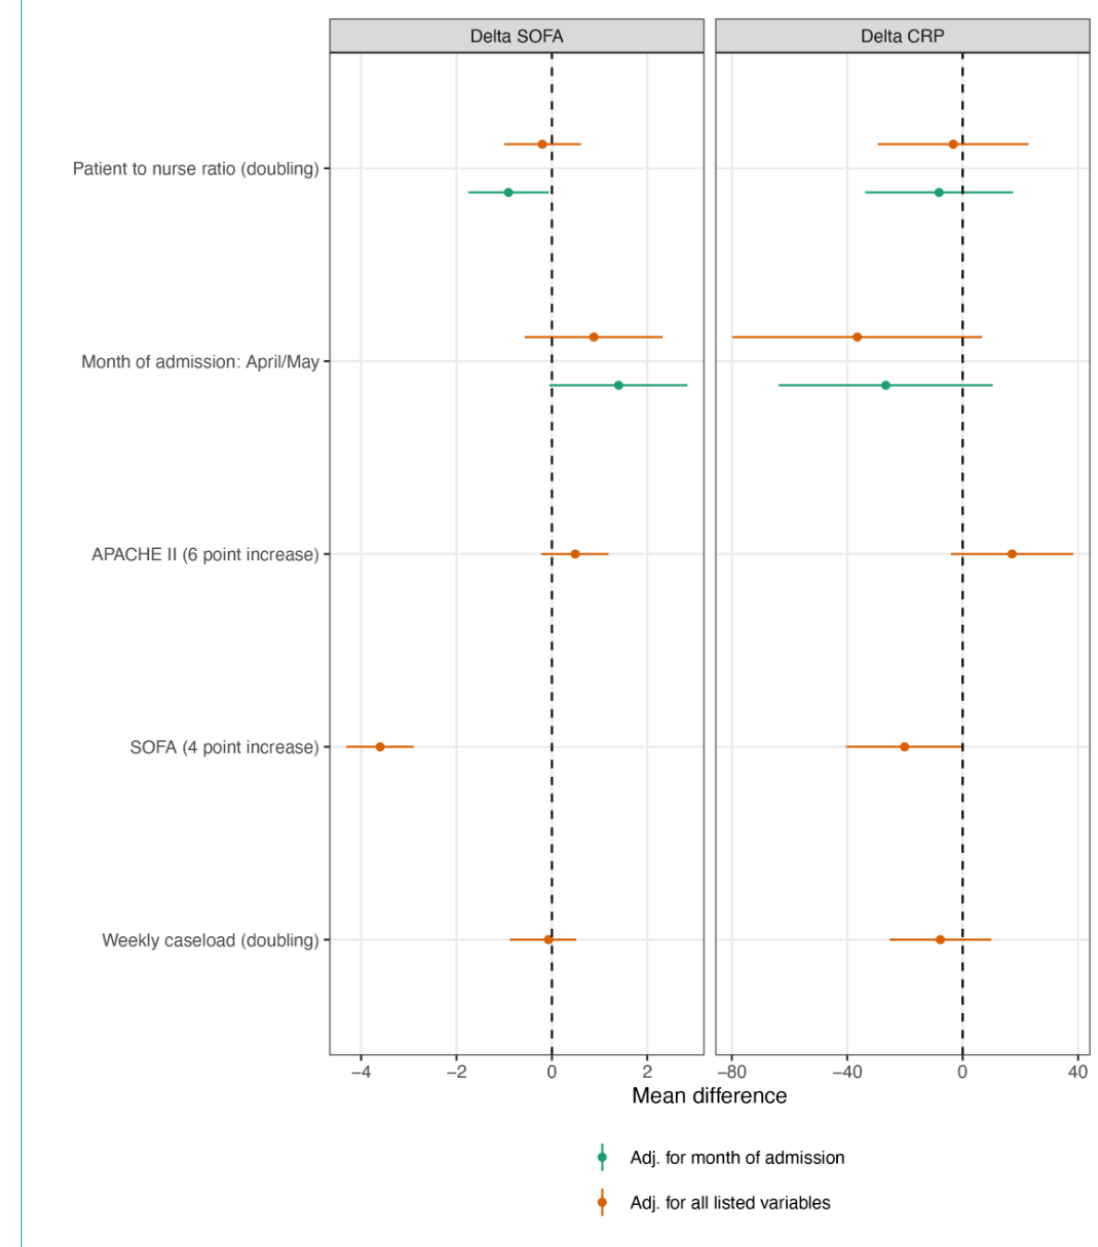
Figure 4: Patient-to-nurse ratio and delta SOFA, delta CRP. APACHE II = Acute Physiology and Chronic Health Evaluation II, SOFA = Se- quential Organ Failure Assessment, CRP = C-reactive